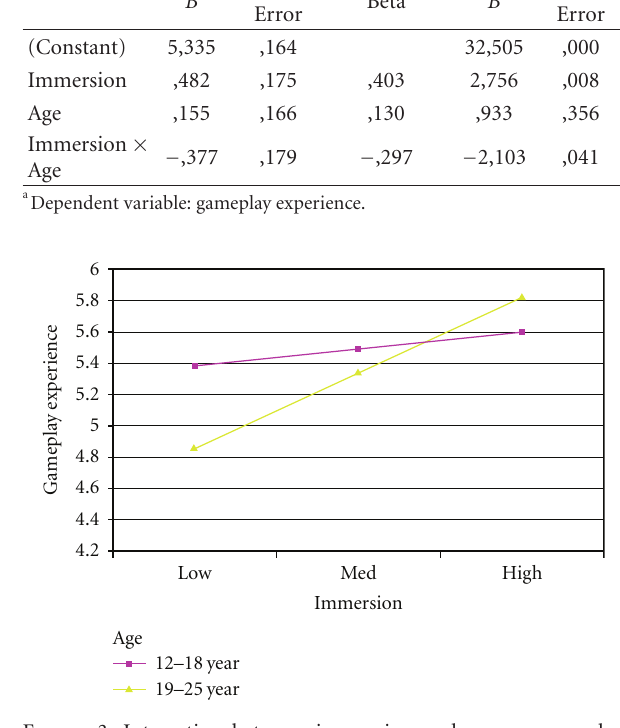
Figure 3: Interaction between immersion and age on gameplay experience.